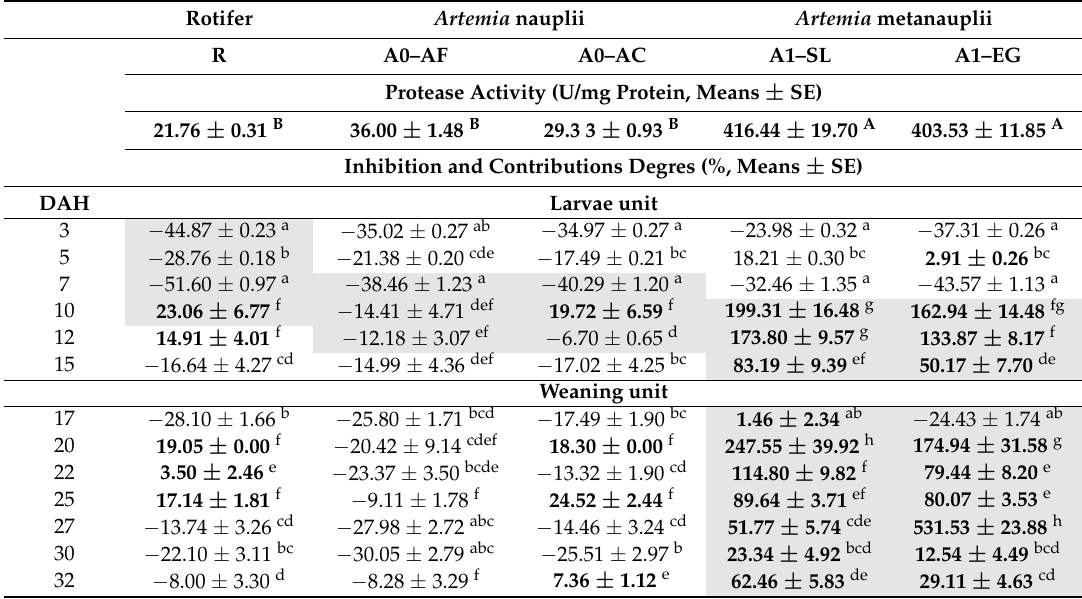
Table 1. Protease activities of live foods and inhibitions and contributions of live foods on protease activities of meagre